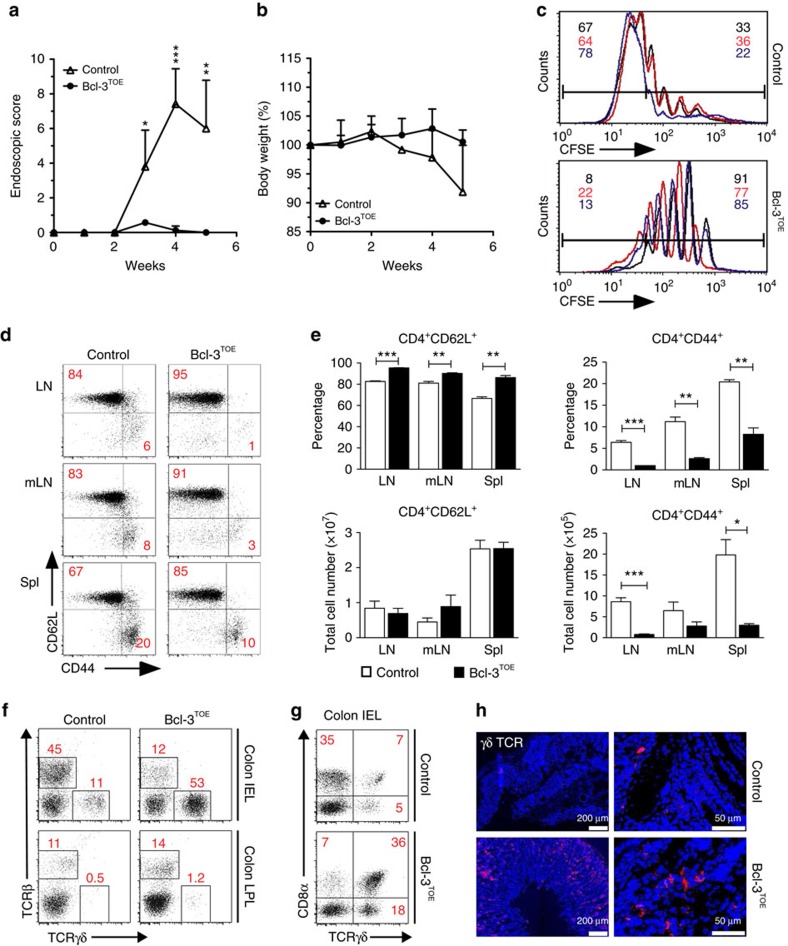
Bcl-3-driven gut inflammation is dominated by γδ T cells.(a,b) Naive CD4+CD25− T cells (5 × 105) from Bcl-3TOE mice (n=4) or controls (n=3) were injected i.p. into RAG1−/− recipients (n=5 per group). Recipients were examined for signs of colitis by mini-endoscopy shown as (a) endoscopic score and (b) body weight loss once a week for 5 weeks (mean±s.e.m.). **P<0.01 and ***P<0.001 using unpaired Student's t-test. (c) In vitro proliferation assay of CD4+CD25− T cells from Bcl-3TOE mice (n=3) and littermate controls (n=3). CD4+ T cells were labelled with CFSE and cultured with anti-CD3/CD28 for 4 days. CFSE dilution was analysed by FACS. Upper histogram: CFSE dilution of control CD4+ T cells (n=3) compared with CD4+ T from Bcl-3TOE mice (n=3) (lower histogram). Numbers represent percentage of proliferated cells. (d) FACS analysis of LN, mLNs and splenic (spl) cells from 8 weeks old Bcl-3TOE mice (n=5) and littermate controls (n=5) pre-gated on CD4+ and analysed for CD44 and CD62L expression. Numbers in quadrants represent percentage. (e) Upper panel: mean percentage and lower panel: total cell numbers of CD4+CD62L+ and CD4+CD62L+ T cells in LN, mLN and spl of Bcl-3TOE mice (n=5) and littermate controls (n=5). Shown is mean±s.e.m. **P<0.01 and ***P<0.001 using unpaired Student's t-test. (f) FACS analysis of intraepithelial lymphocytes (IEL) and LPL from colon of indicated mice (n=3). Cells were gated on live cells and analysed for TCRβ and TCRγδ expression. Numbers represent percentage. (g) FACS analysis of IEL of Bcl-3TOE mice (n=3) compared with littermate controls (n=3). Cells were analysed for CD8α and TCRγδ surface expression (percentage displayed). (h) Representative immunohistochemistry of colonic cryosections from indicated mice stained for TCRγδ (red). Nuclei were counterstained with Hoechst 3342 (blue). Scale bars, 50 μm (right) and 200 μm (left), n=5. Data shown are representative for at least three independent experiments with similar results. Bcl-3OE littermate mice without Cre were used as controls.